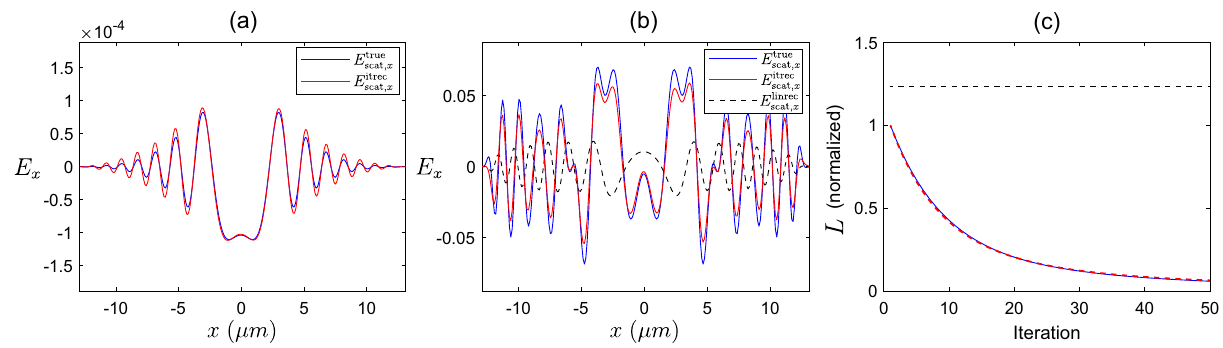
Figure 3. ( a ) x -component of the time-dependent scattered field measured on (cid:31) b for the true point-like sample, F true F itrec 1 (blue), and for the iterative solver reconstruction, 1 (red) at timestep 1620 of the PSTD simulation. ( b ) x -component of the time-dependent scattered field measured on (cid:31) b for the true high contrast disk sample, F true 3 (blue), for the iterative solver reconstruction, F itrec 3 (red), and for the linear reconstruction (black dashed) at timestep 2070 of the PSTD simulation. ( c ) cost metric, L , normalized to the initial value (with an empty estimate for the scattering potential) over 50 iterations of the iterative solver for the point scatterer (blue), and for the high constrast disk (red dashed). Also shown is the normalized cost metric value for the linear reconstructed sample (black dashed).